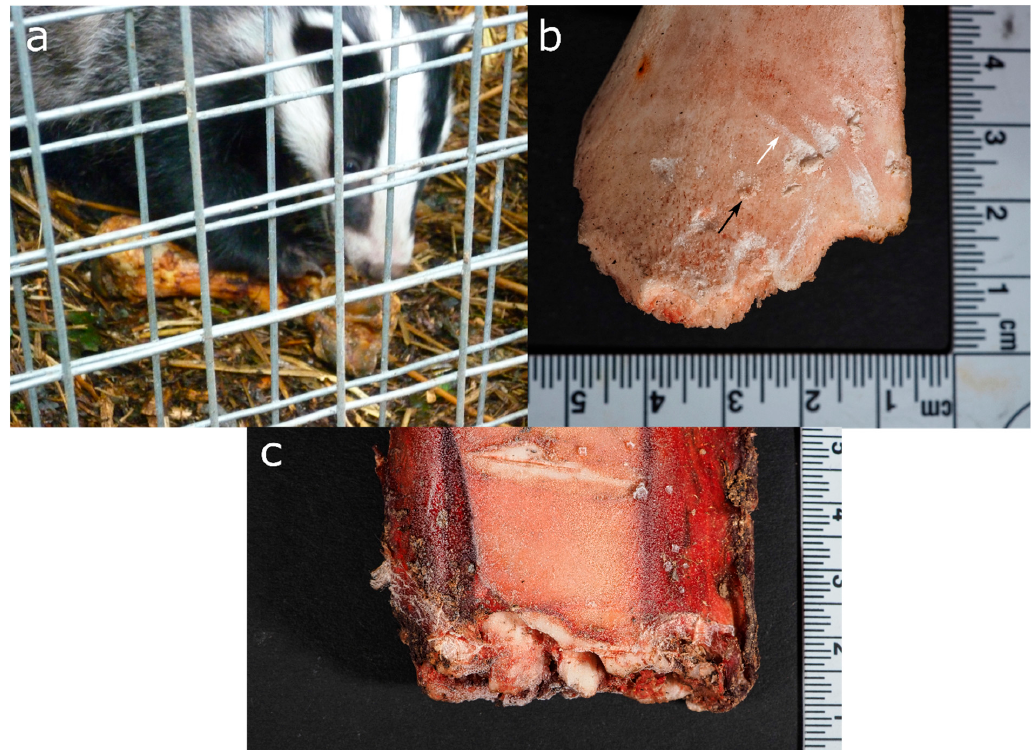
Figure 6. Scavenging experiments (from UK and Switzerland) with captive Eurasian badgers demonstrate ( a ) holding of a pig long bone with its claws and ( b ) removing of the epiphysis of a large herbivore long bone shaft, leaving an uneven, crenulated margin with pits (black arrow) and scores (white arrow), ( c ) a bovine rib end with irregular margins and crushed bone.